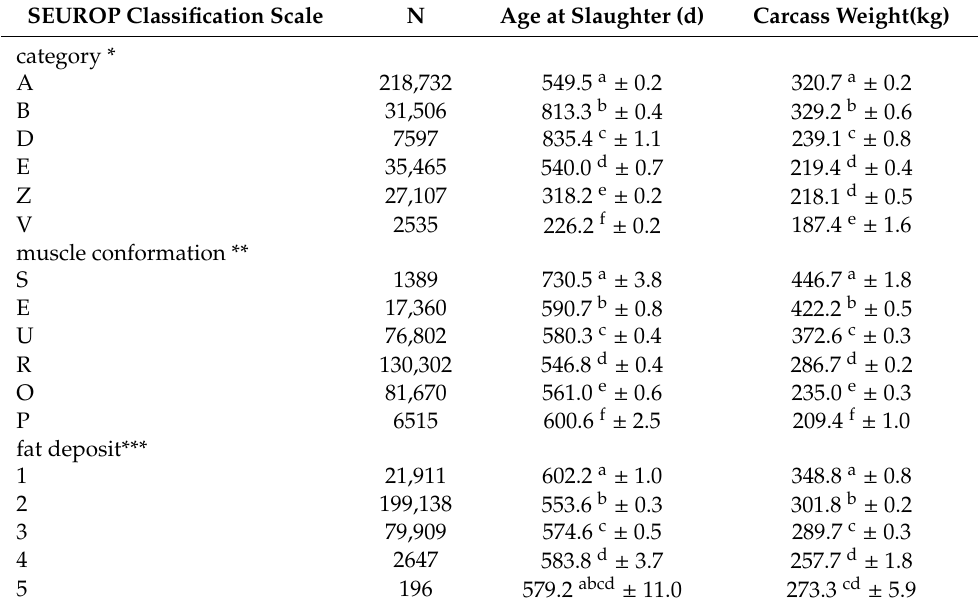
Table 5. Number of beef carcasses (N), means ± std. error for the age at slaughter (days, d) and the carcass weight (kg) according to SEUROP classification scale 1 (category, muscle conformation and fat